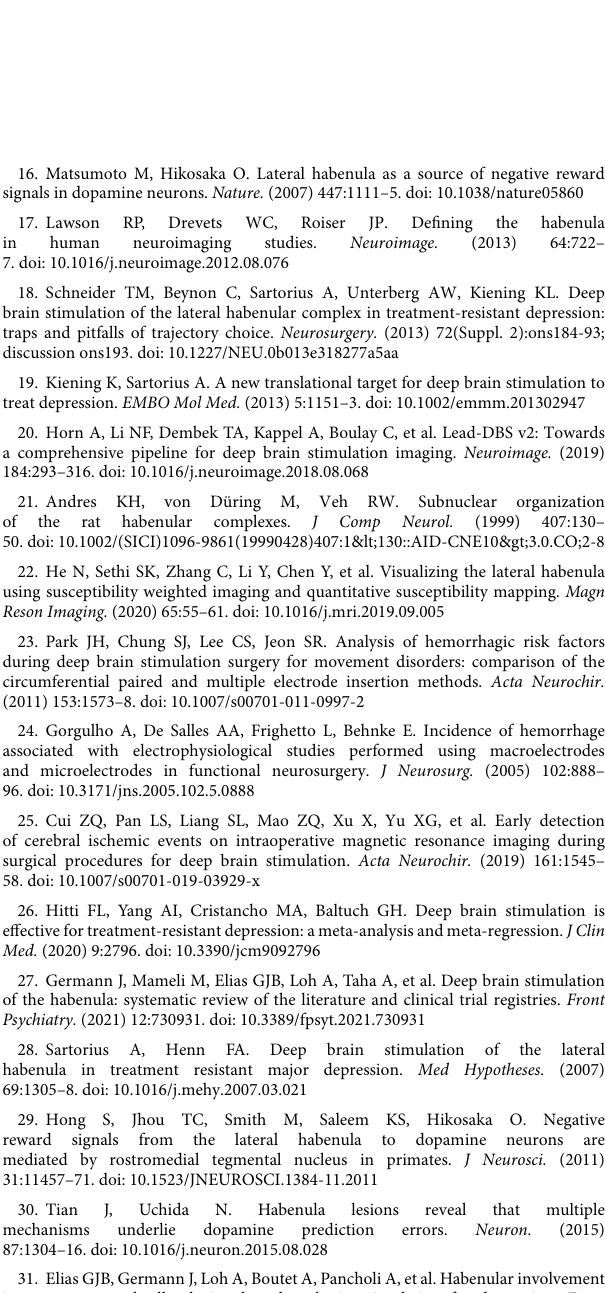
SUPPLEMENTARYFIGURE1 An example of a 4s single-channel microelectrode recording signals of the right Hb in patient 2. The discharge pattern at 2.135mm is considered as belonging to the thalamus and the patterns at 1.850 and 0.604mm belonging to the Hb. The discharge disappeared at − 1.330mm, considering the microelectrode was out of the